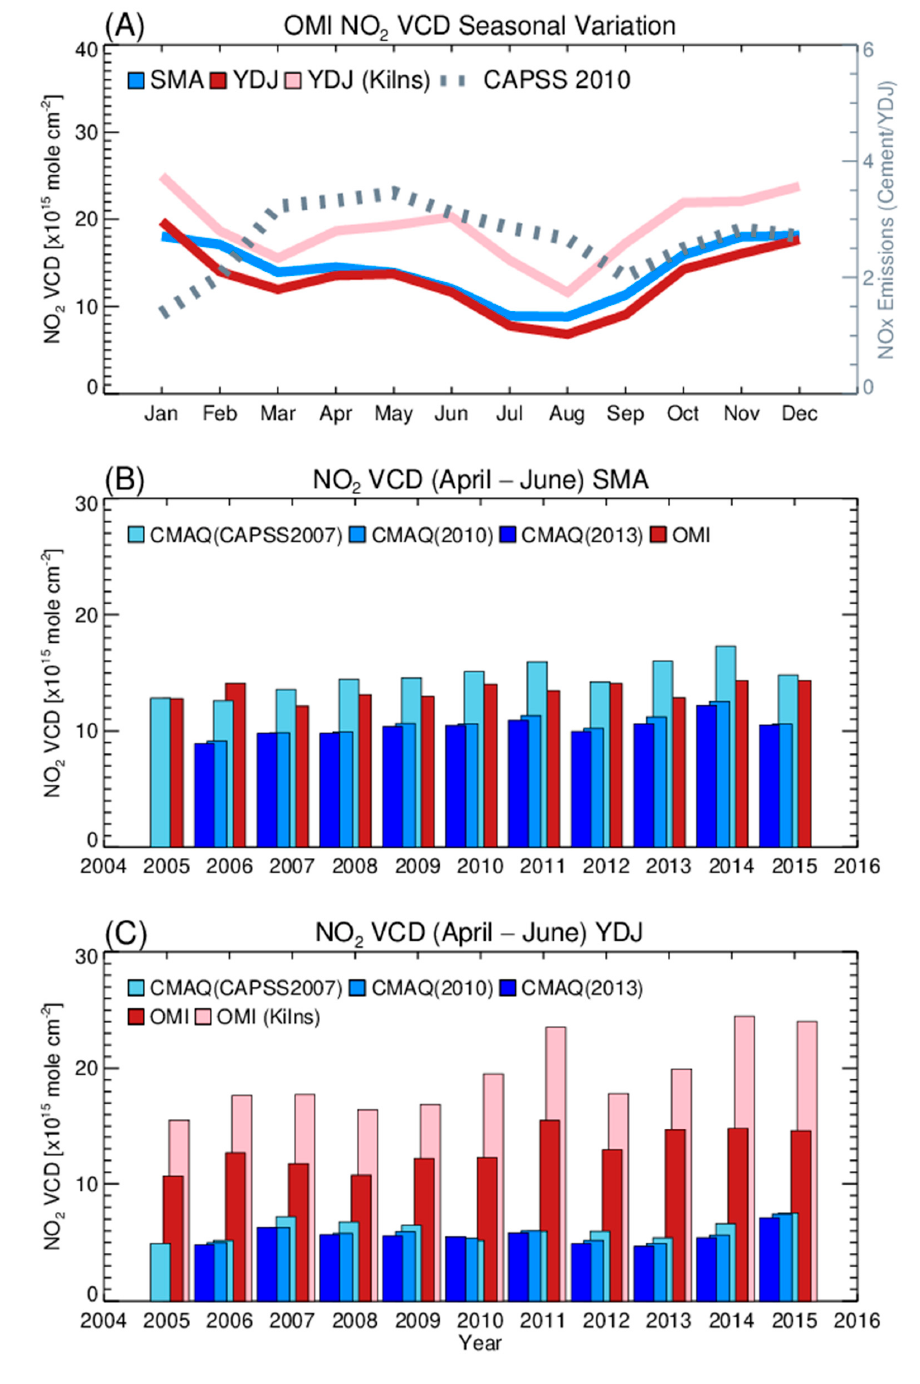
Figure 3. ( A ) Annual variation in OMI NO 2 VCD over the Seoul Metropolitan Area (SMA), YDJ, YDJ (kilns), and YDJ NO x emissions (six cement kilns, CAPSS 2010). Inter-annual changes in OMI and CMAQ NO 2 VCDs (April to June 2005–2015) ( B ) over the SMA and ( C ) over the